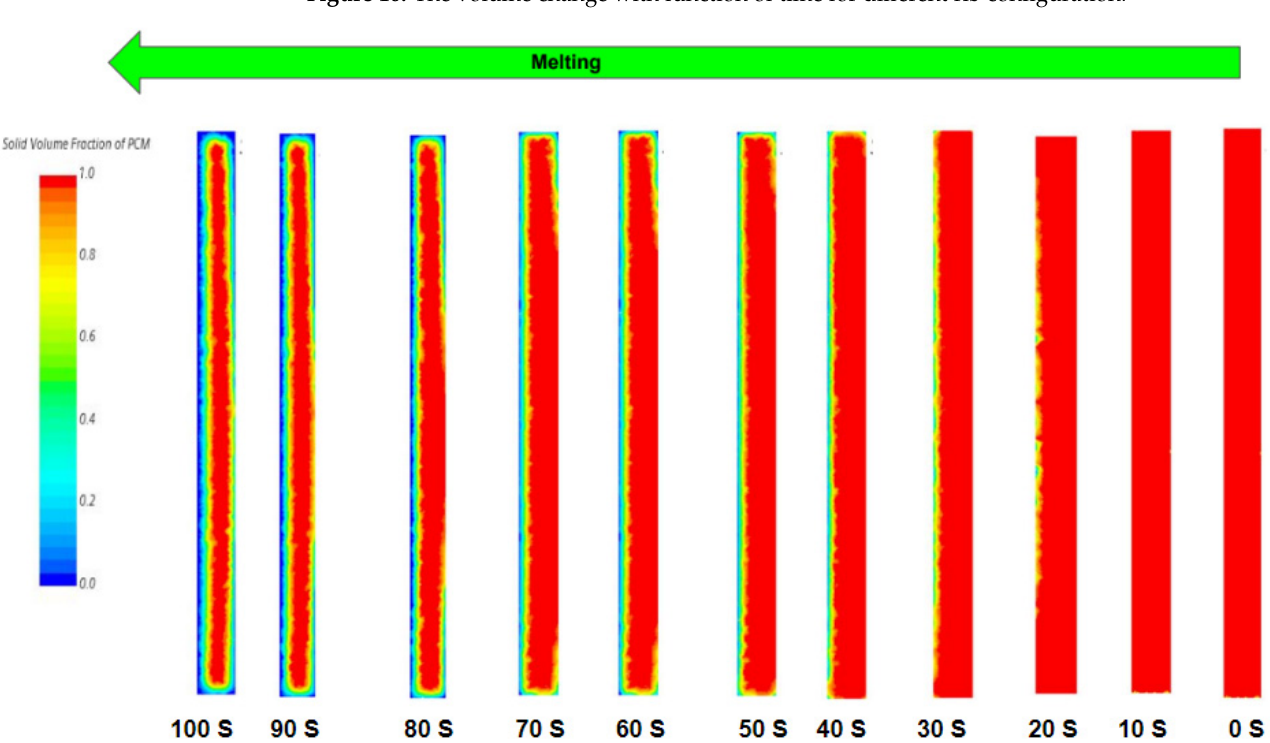
Figure 11. The volume change with function of time for no rib configuration.